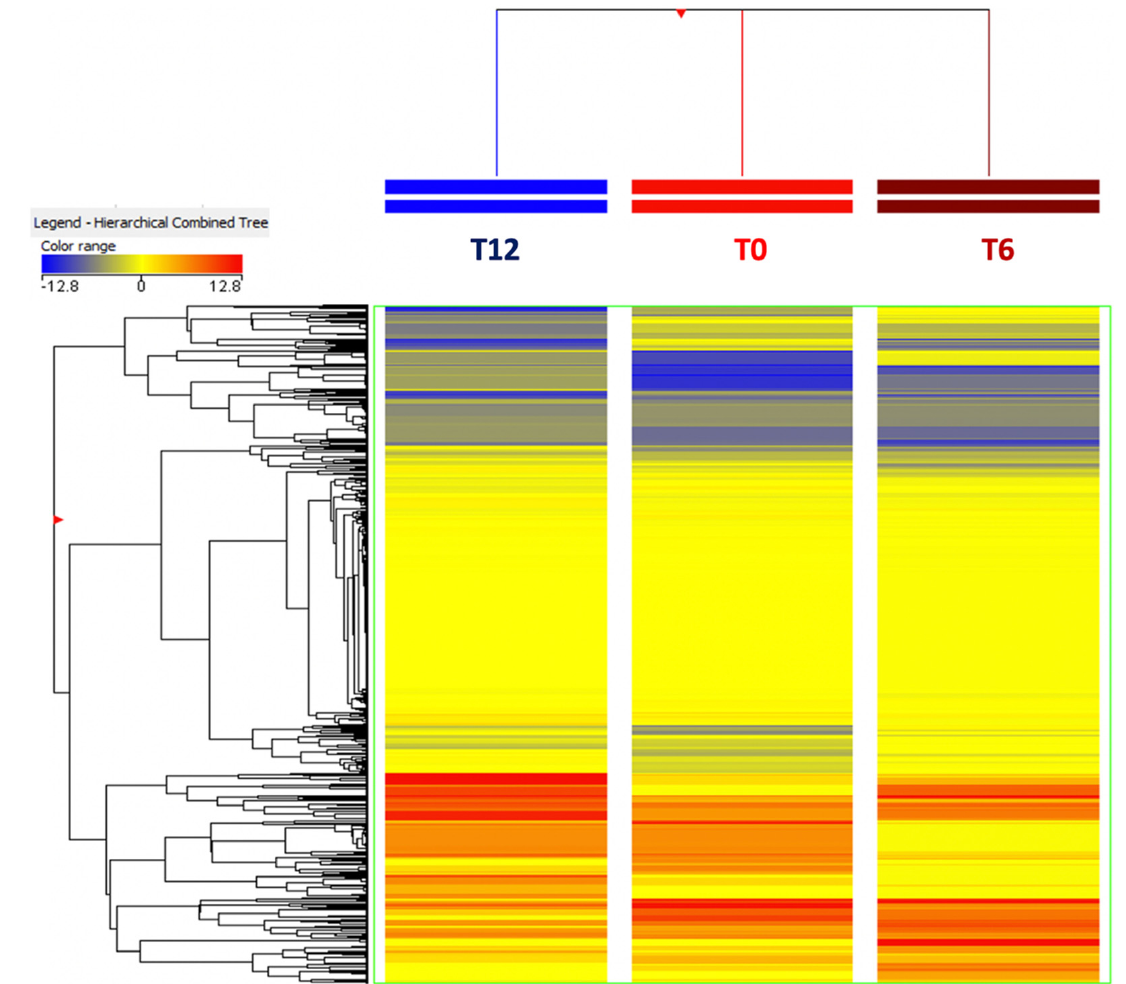
Figure 4. Average unsupervised hierarchical cluster analysis (HCA) built considering the shelf-life period of the ricotta samples (T0 = 0 days; T6 = 6 days; T12 = 12 days).